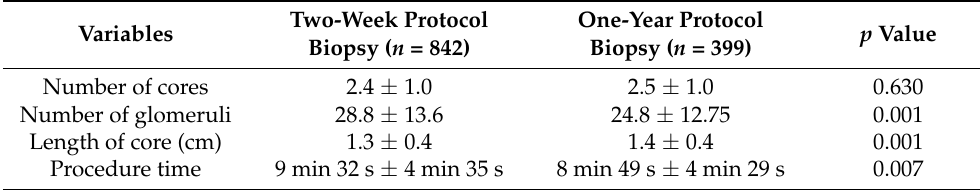
Table 2. Comparison of protocol biopsies by technique and outcome.